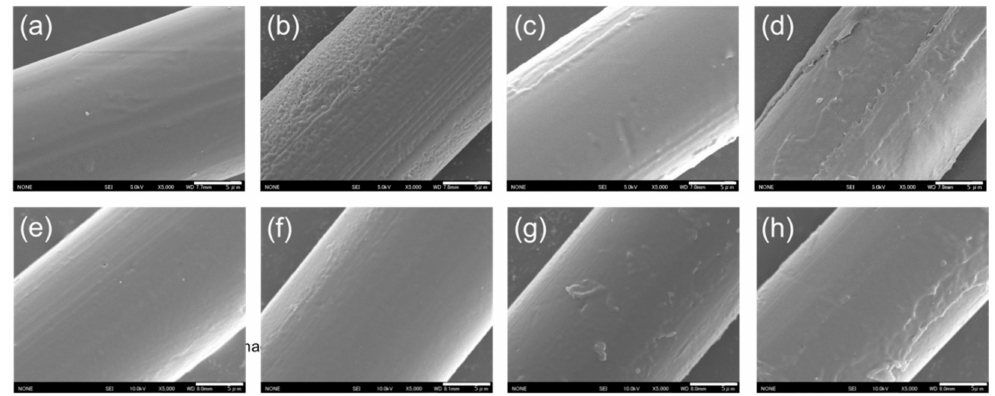
Figure 9. SEM images of PLA fibers: ( a ) P1; ( b ) P3; ( c ) C3; and ( d ) C5 before degradation testing; and ( e ) P1; ( f ) P3; ( g ) C3; and ( h ) C5 after six months in PBS (magnification: 5000 × , scale bar: 5 µ